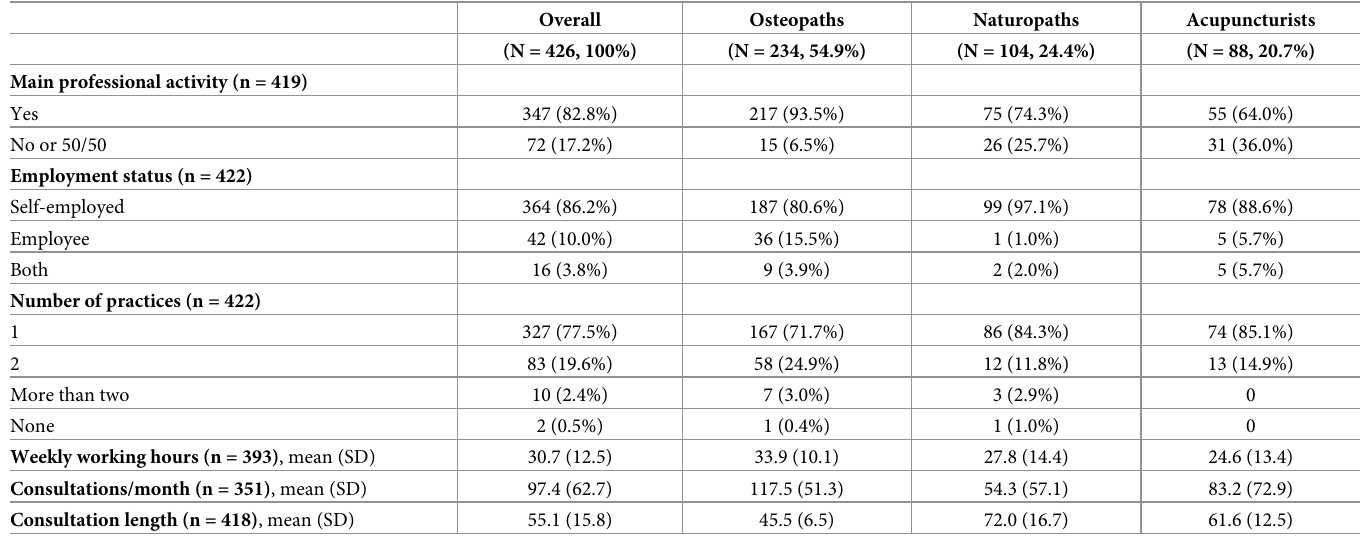
Table 4. Practice